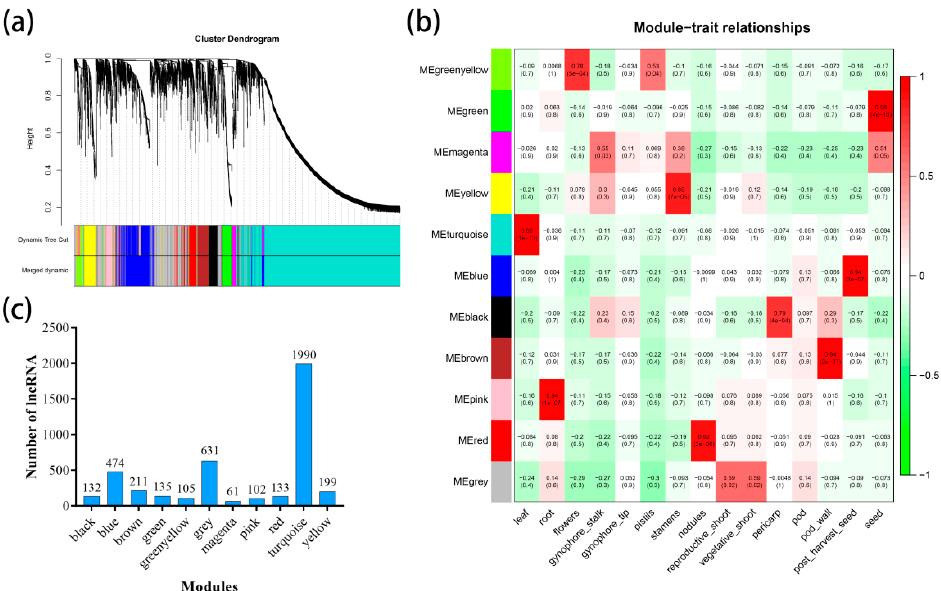
Figure 4. Weighted gene co-expression network analysis (WGCNA) of lncRNAs in all samples. ( a ) Hierarchical cluster tree showing 11 modules of co-expressed lncRNA. Each of the 4713 lncRNAs is represented by a leaf in the tree while each of the 11 modules by a major tree branch. The lower panel shows modules in designated colors. ( b ) Heatmaps showing correlation of module eigengenes with different tissues of peanut. Pearson correlation coefficient of each module with different tissues are given and colored according to the score. ( c ) Number of lncRNA in each module.